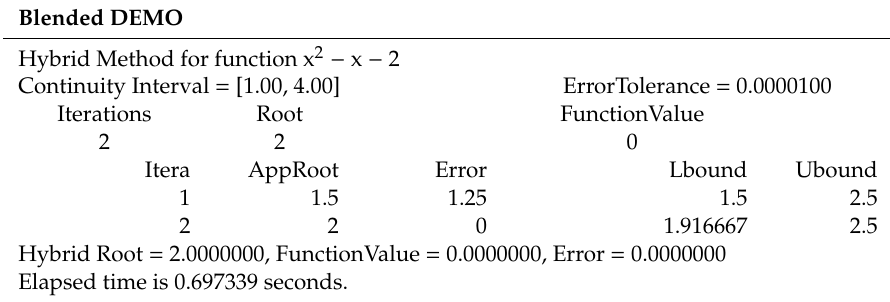
Table 3. Blended algorithm e ffi ciency iterations, AppRoot, error and interval bounds.